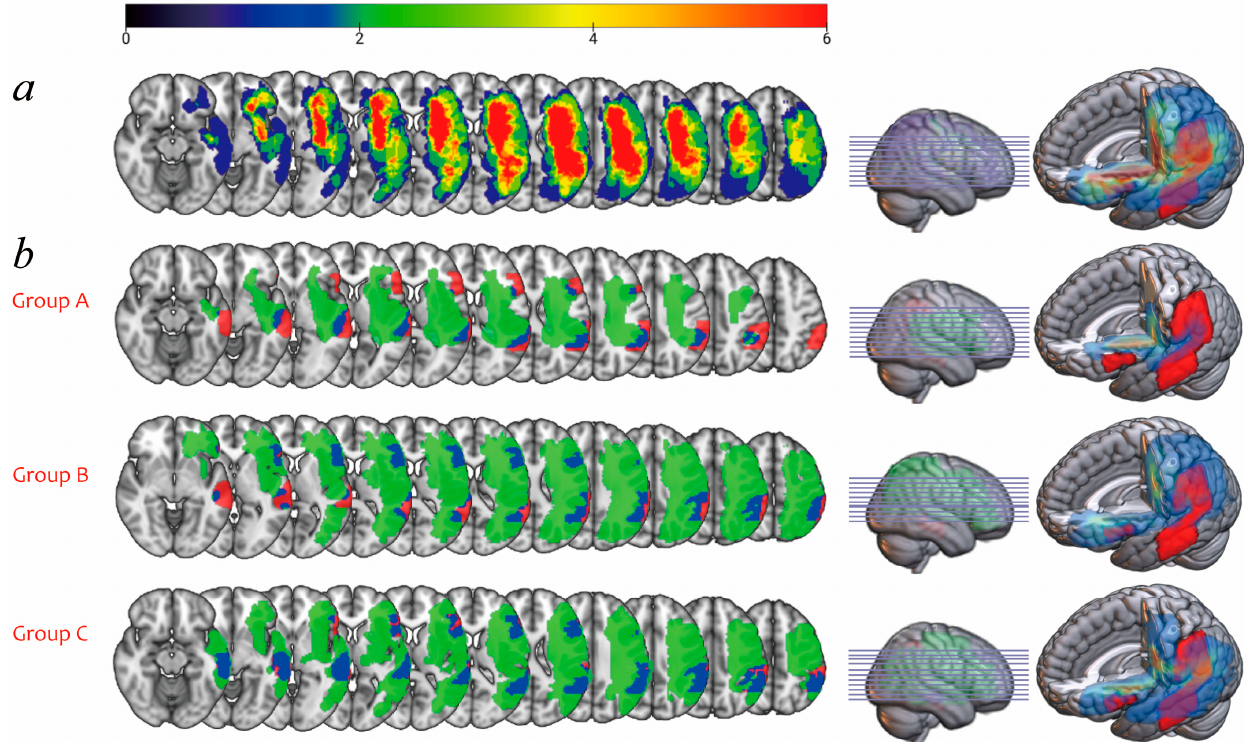
Figure 4. Lesion overlay maps. ( a ) The lesion-overlay map for all 26 patients with PSA. The cold color represents the areas with less lesion overlap, while the hot color represents the areas with high lesion overlap; ( b ) the lesion map of the three groups of patients. The red regions represent the left cortical language areas, the green regions represent the stroke lesion distribution of the patients, and the blue regions represent the overlapping areas between the cortical language areas and stroke lesions.